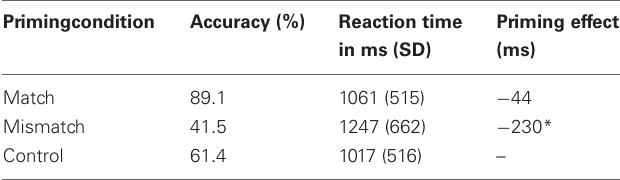
Table 2 | Mean reaction times and accuracy for target